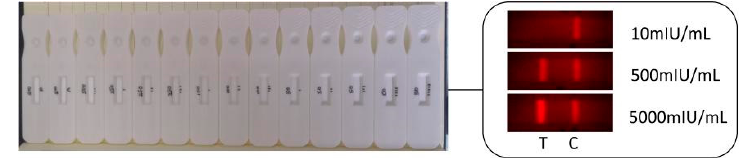
Figure 5. HCG test strips and collected images.